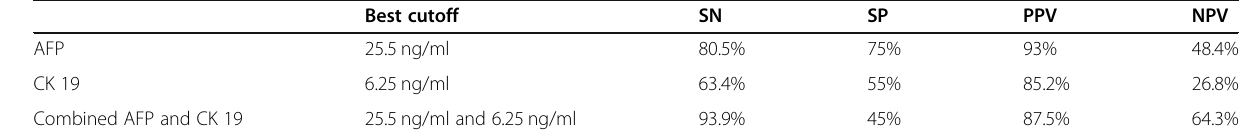
Table 2 Sensitivity, specificity, positive, and negative predictive values of AFP and CK 19 in studied patients